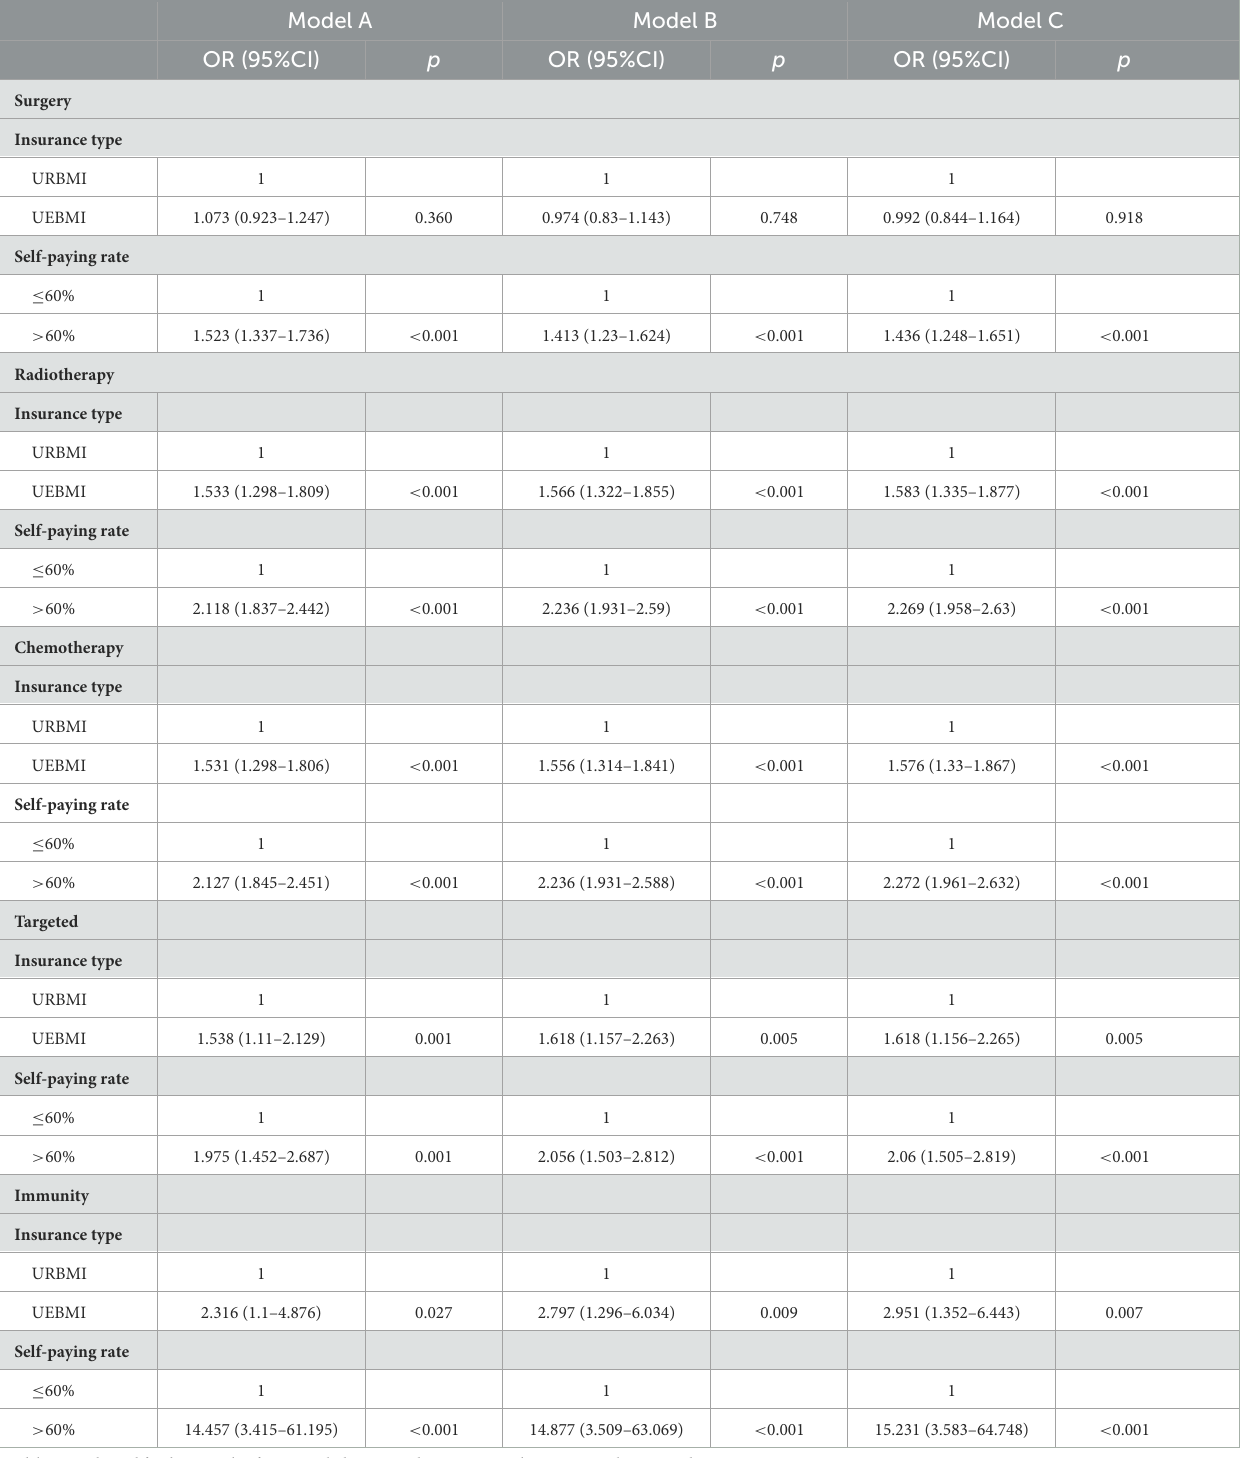
TABLE 3 Associations of insurance type and self-paying rate with treatment type.